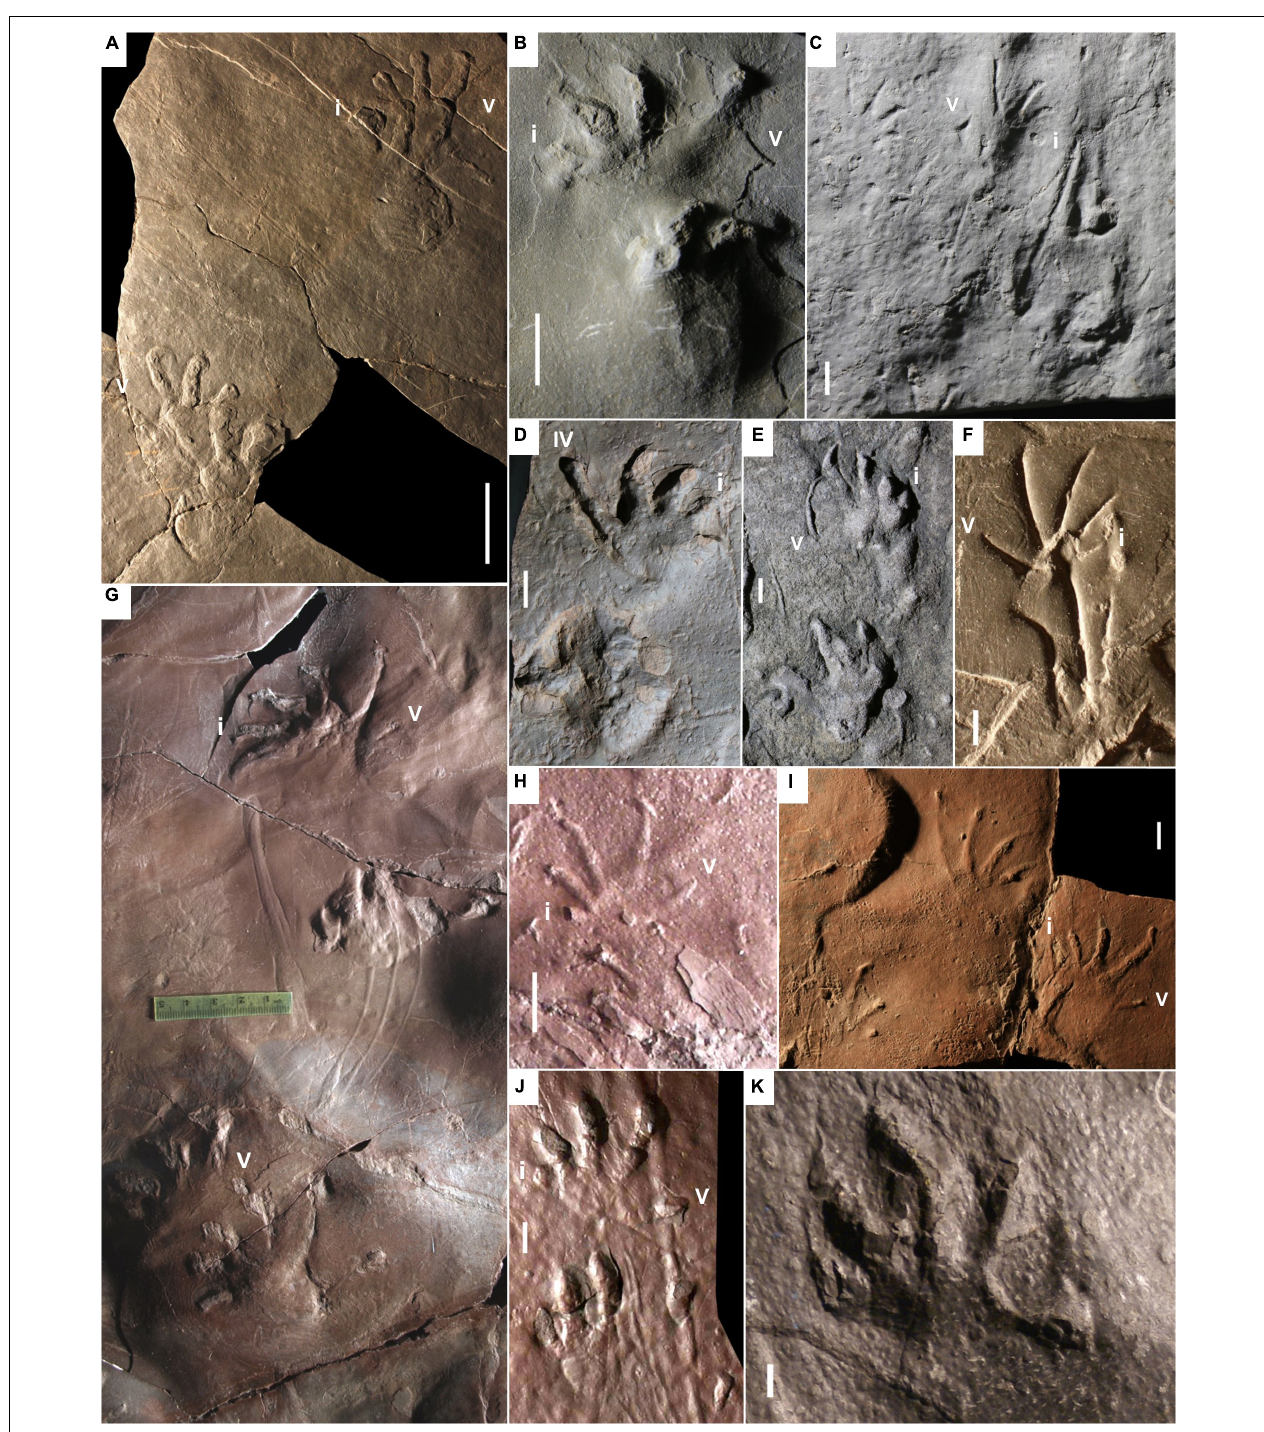
FIGURE 4 | Carboniferous anamniote reptiliomorph tracks, additional material of Hylopus hardingi . (A) MCZ 267, two consecutive pes-manus couples, convex hyporelief. West Bay Formation, Nova Scotia. (B) NSM 008GF031.142, left pes-manus couple, convex hyporelief. Joggins Formation, Nova Scotia. (C) NSM 008GF039.336. Two left pes-manus couples. Joggins Formation, Nova Scotia. (D) NBMG 10128-1, right pes-manus couple, convex hyporelief. Enrage Formation, New Brunswick. (E) NBMG 14143, right pes-manus couple, convex hyporelief. Grande Anse Formation, New Brunswick. (F) UCM 263 JT, left pes-manus couple, concave epirelief. Pottsville Formation, Alabama. (G–J) Mauch Chunk Formation, Pennsylvania. (G) SMP-IP 8789, two consecutive left pes-manus couples, impression of digit I basal pad, tail impression and digit scratches, convex hyporelief. (H) SMP-VP 2325, left pes-manus couple, convex hyporelief. (I) MCZ-NN 1, isolated tracks, convex hyporelief. (J) RPM 1011, left pes-manus track, convex hyporelief. (K) DBM-NN 1. Left pes imprint, convex hyporelief. Germany. Manual digits indicated by Roman numbers. Scale bar (A) is 5 cm, scale bars (B–F,H–K) are 1 cm.